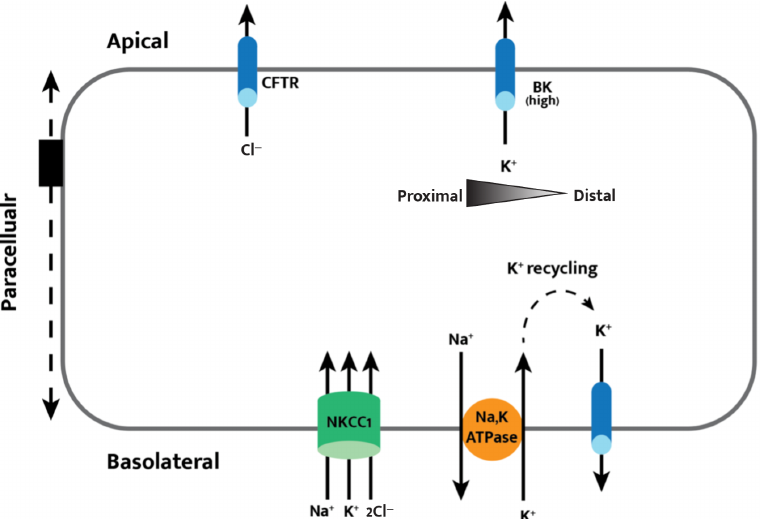
Figure 2. Cell model of transepithelial chloride secretion. Basolateral intake through NKCC1 of sodium, potassium, and chloride allow for apical secretion of chloride through CFTR. Apical BK channel expression is higher in the proximal colon, leading to an observed net potassium secretion in the proximal colon and net potassium absorption in the distal colon. The apical and basolateral membranes are functionally coupled by the paracellular pathway, acting as a potential shunt for ions and fluid that is essential in secretory epithelia. 2.2. Sodium – Potassium – Chloride Cotransporter Type 1 (NKCC1) To maintain homeostatic intracellular Cl − concentrations while also achieving transepithelial chloride secretion, chloride must be absorbed from the basolateral membrane in parallel with apical secretion by CFTR (Figure 2) [4,14,17]. NKCC1 was first described upon observing cDNA isolated from shark tissue in 1994 [22]; shortly after, the human homologue of the protein was found to be 1212 amino acids long, have 12 transmembrane segments, and aid transcellular movement of chloride by facilitating electroneutral ion transport with a 1 Na + , 1 K + , and 2 Cl − stoichiometry [23]. NKCC1 enables transepithelial Cl − and K + secretion by allowing Na + , K + , and Cl − into crypt and surface cells on the basolateral membrane. NKCC1 is upregulated during increased apical efflux of chloride through an intracellular Cl − sensing mechanism that ensures a homeostatic electrochemical equilibrium of Cl − in epithelial cells [4]. NKCC1 also provides intracellular potassium essential for K + secretion through apical potassium channels, as demonstrated by decreased capacity for potassium secretion by the apical surface in the presence of the NKCC1 inhibitor bumetanide [24,25]. This model of basolateral NKCC1 cotransport facilitating chloride and potassium extrusion follows a common theme of basolateral and apical ion transporters working in unison to accomplish transepithelial ion secretion or absorption. 2.3. Cystic Fibrosis Transmembrane Conductance Regulator (CFTR) The gene encoding the dysfunctional mutant CFTR chloride channel (the genetic basis for cystic fibrosis) was “the first disease gene to be isolated without the use of